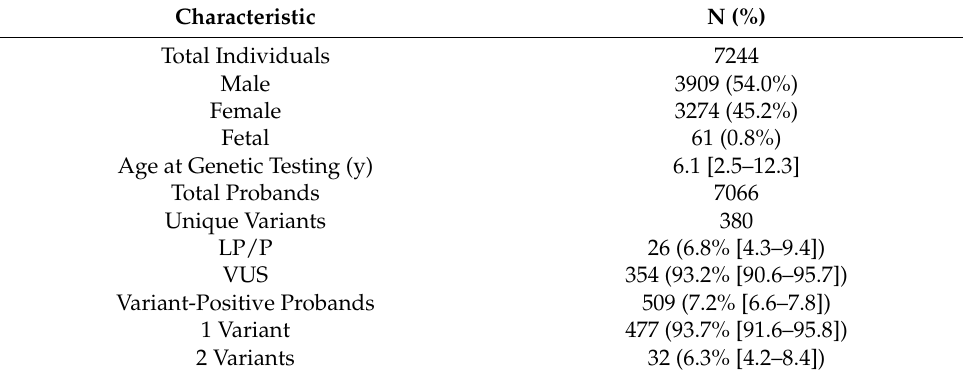
Table 1. Exome sequencing cohort demographics at time of genetic